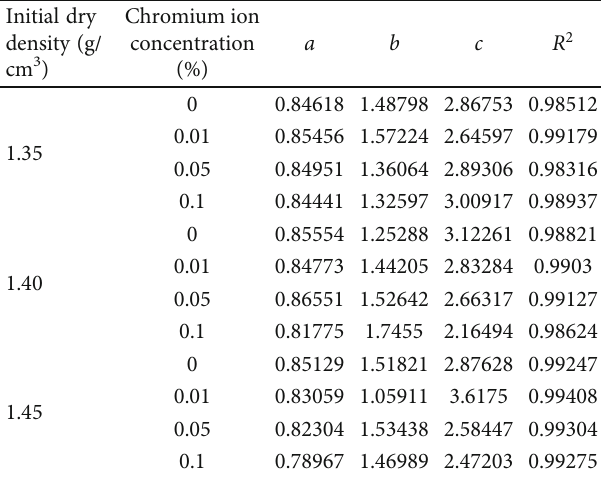
Figure 7: The relationship between secant modulus and axial strain at di ff erent dry densities. (a) The initial dry density is 1.35 g/cm 3 , 100kPa. (b) The initial dry density is 1.35g/cm 3 , 300kPa. (c) The initial dry density is 1.40g/cm 3 , 100 kPa. (d) The initial dry density is 1.40g/cm 3 , 300 kPa. (e) The initial dry density is 1.45g/cm 3 , 100 kPa. (f) The initial dry density is 1.45 g/cm 3 ; 300kPa. Table 9: Fitting table of the relationship between 100kPa secant modulus and axial